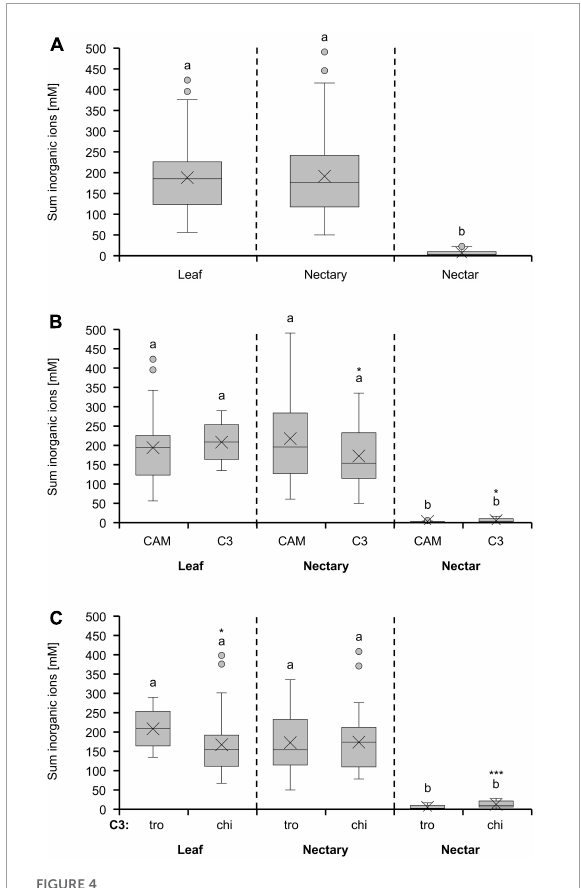
FIGURE4 Sum of 8 inorganic ions (anions: Cl - , PO 43 - , SO 42 - , NO 3 - ; cations: K + , Na + , Mg 2 + , Ca 2 + ) in leaf, nectary and nectar. Boxplot diagram (A) shows data including all 36 bromeliad species ( n = 3). Additionally, the data were separated by photosynthesis type (B) and pollinator type (C) . The separation according to photosynthesis type includes 14 CAM and 22 C3 species. All CAM species have trochilophilous pollinators whereas the C3 species have either trochilophilous (tro) or chiropterophilous (chi) pollinators. Therefore, the C3 species were separated according to the pollinator type in 11 trochilophilous (tro) and 11 chiropterophilous (chi) species. Different letters represent significant differences in sum of amino acids between leaf, nectary and nectar (Tukey’s HSD; p < 0.05). The asterisks show different levels of